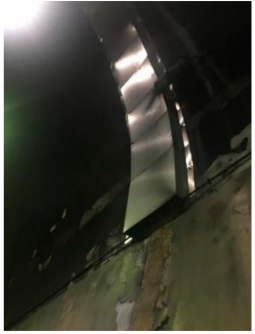
Figure 1. Water receiver at lining leakage.